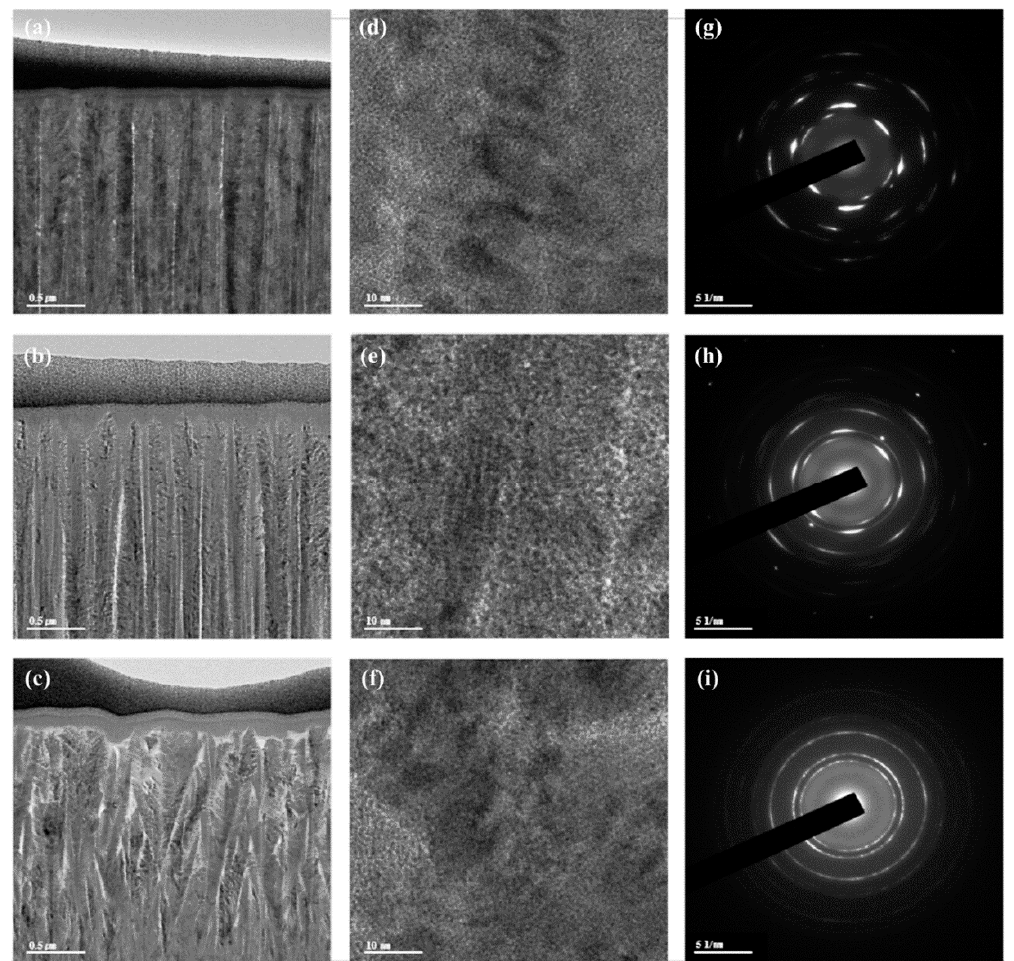
Figure 5. Cross-section TEM images: ( a ) as-deposited TiZrN, ( b ) 20% laser output, and ( c ) 40% laser output. IFFT images: ( d ) as-deposited TiZrN, ( e ) 20% laser output, and ( f ) 40% laser output. SAED patterns: ( g ) as-deposited TiZrN, ( h ) 20% laser output, and ( i ) 40% laser output.